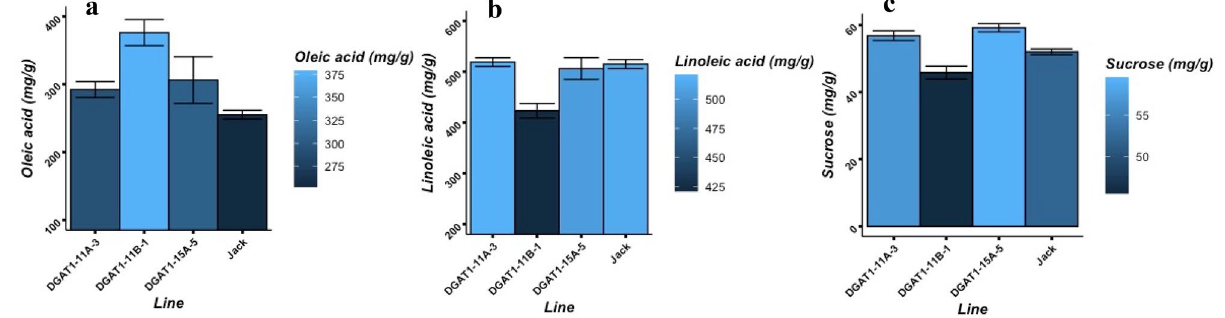
Figure 6. Functional impact of DGAT1 down-regulation on fatty acids composition and sucrose concentration. ( a ) Oleic acid (C18:1) concentration. ( b ) Linoleic acid (C18:2) concentration. ( c ) Sucrose concentration. The presented values are mean ± SE measured using three independent replicates.